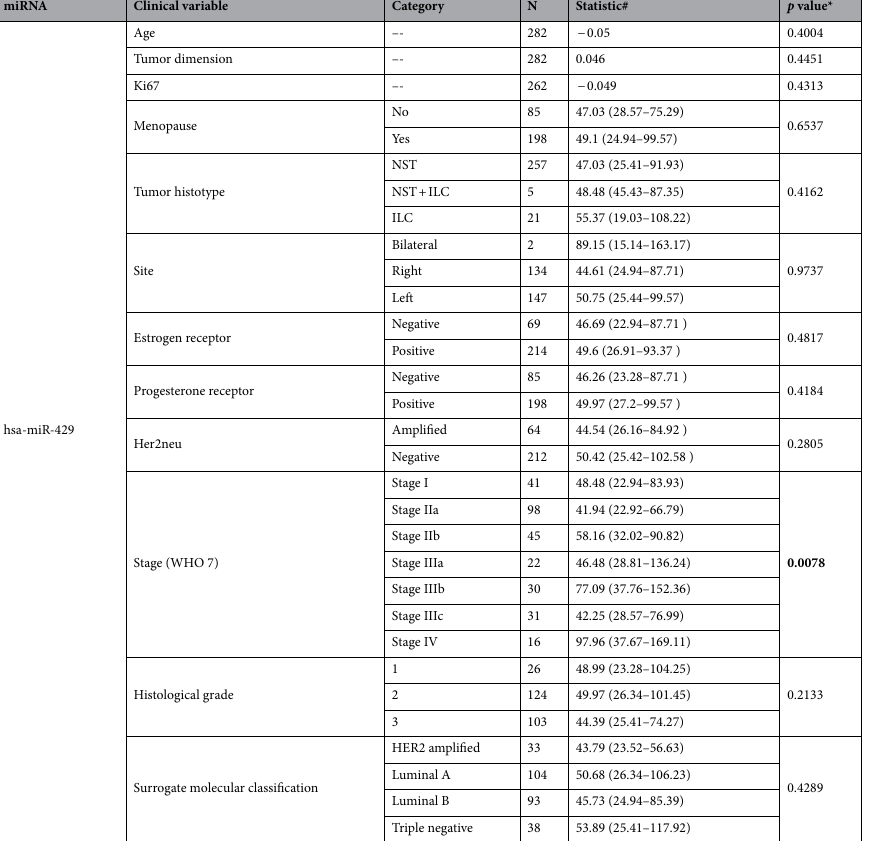
Table 2. Association between miRNAs and clinicopathological variables. # In case of continuous clinical variables (i.e. age, tumour dimension and Ki67), r denotes Pearson correlation coefficient with log-transformed miRNA expression whereas in presence of categorical clinical variables, median along with interquartile range (IQR, i.e. first-third quartiles) of the miRNA expression was reported. * p values from Pearson correlation or two-sample t test (or ANOVA model as appropriate) using log-transformed miRNA expressions was reported for continuous and categorical variables, respectively. p -value <0.05 are reported in